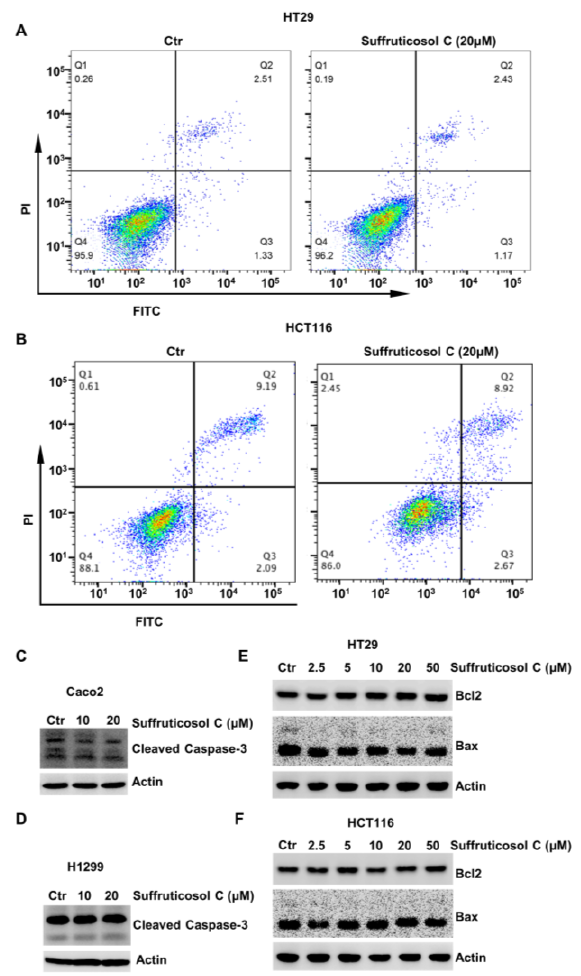
Figure 2. The apoptosis-independent inhibitory effect of suffruticosol C on the growth of various cancer cells. HT29 ( A ) and HCT116 ( B ) cells were treated with suffruticosol C for 24 h, and apoptosis was examined using FACS. Caco2 ( C ) and H1299 ( D ) cells were treated with suffruticosol C for 24 h, and the level of cleaved caspase-3 was detected by WB. HT29 ( E ) and HCT116 ( F ) cells were treated with suffruticosol C for 24 h, and the level of Bcl-2 and Bax were detected by